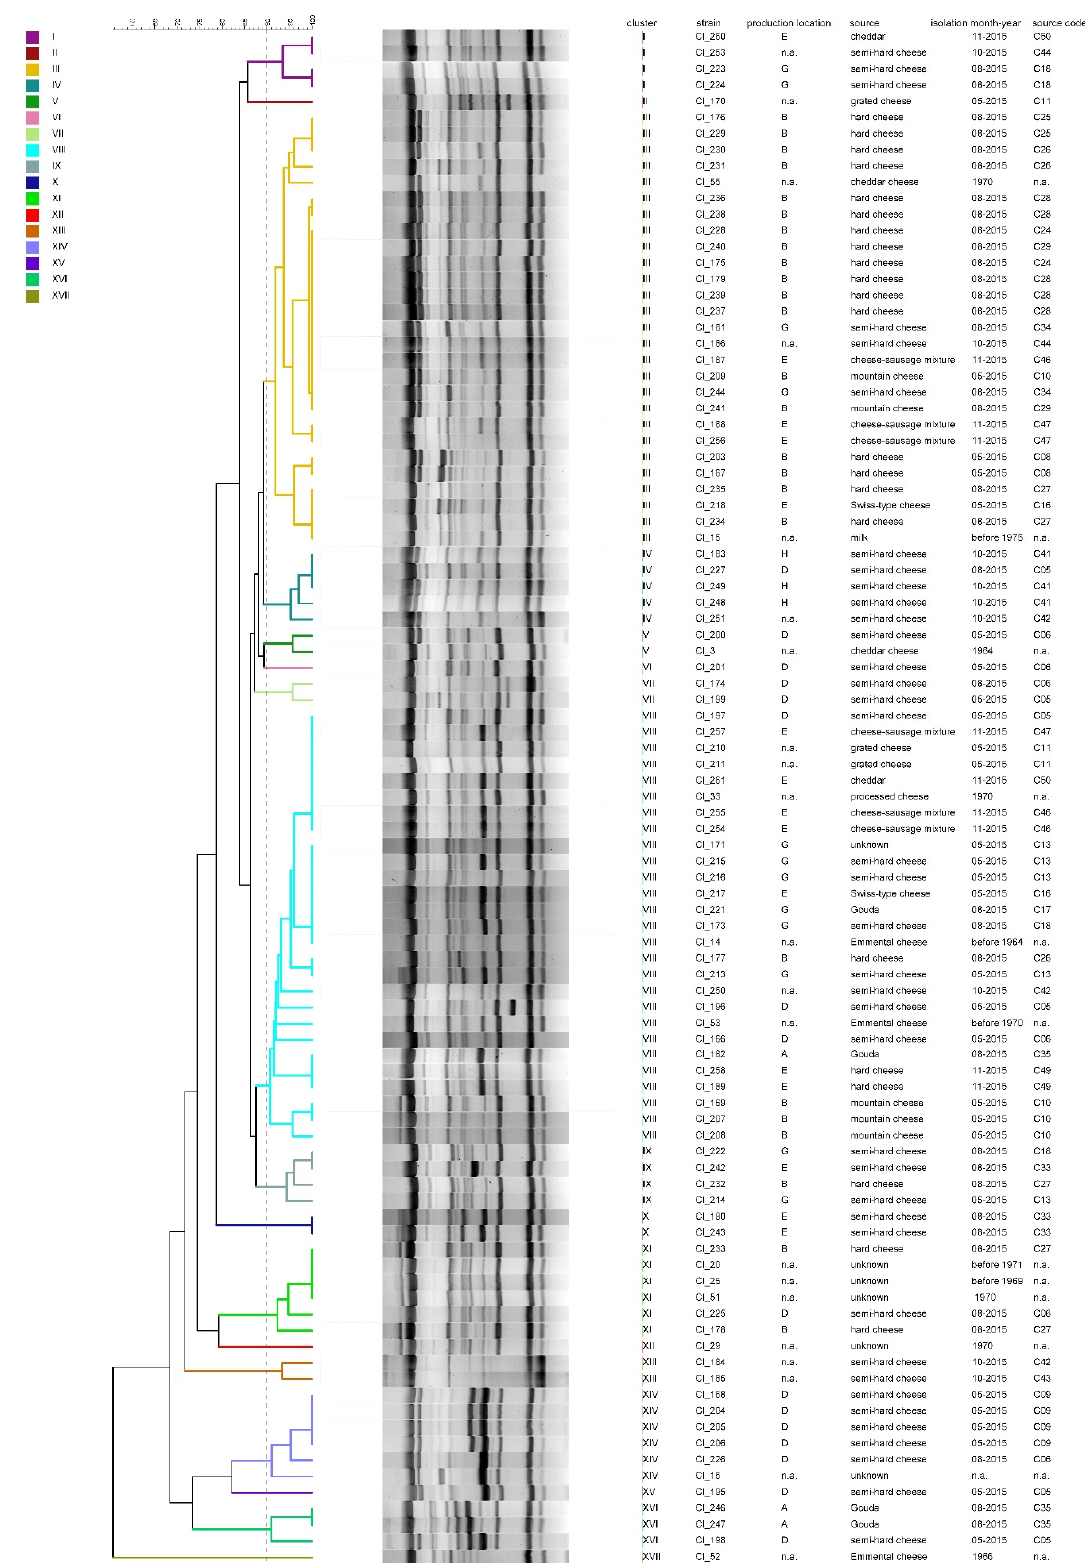
Figure 6. Dice clustering dendrogram of rep-PCR (GTG)5 fingerprints of 95 C. tyrobutyricum strains. The dendrogram was constructed using the unweighted pair group method using arithmetic mean (UPGMA) with similarity levels expressed as percentage values of Dice’s correlation coe ffi cient. The vertical grey dashed line indicates the threshold similarity level (90%) for cluster formation. n.a.: not